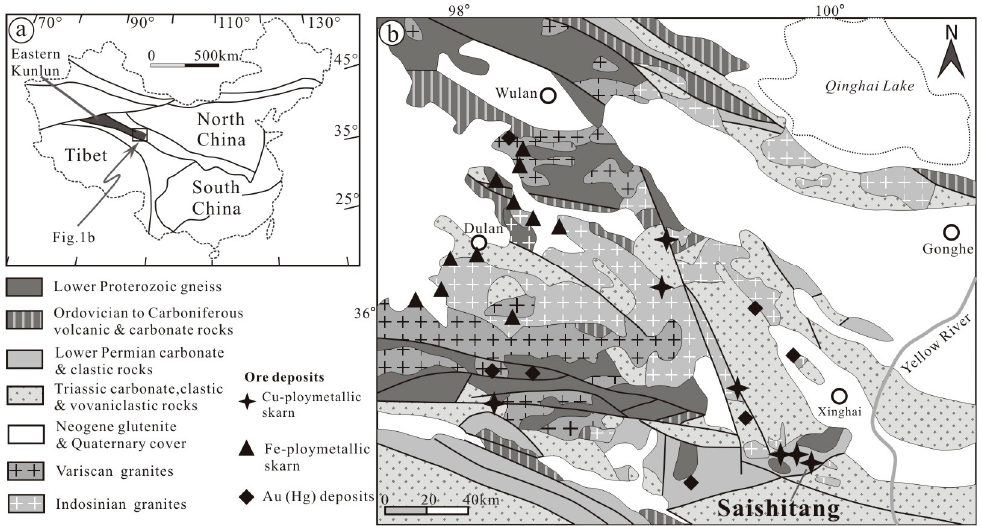
Figure 1. ( a ) Tectonic maps indicating the location of the Elashan Region, Northwest (NW) China; ( b ) Simplified geological map and skarn deposits of the Elashan Region (after Refs. [33,34]).